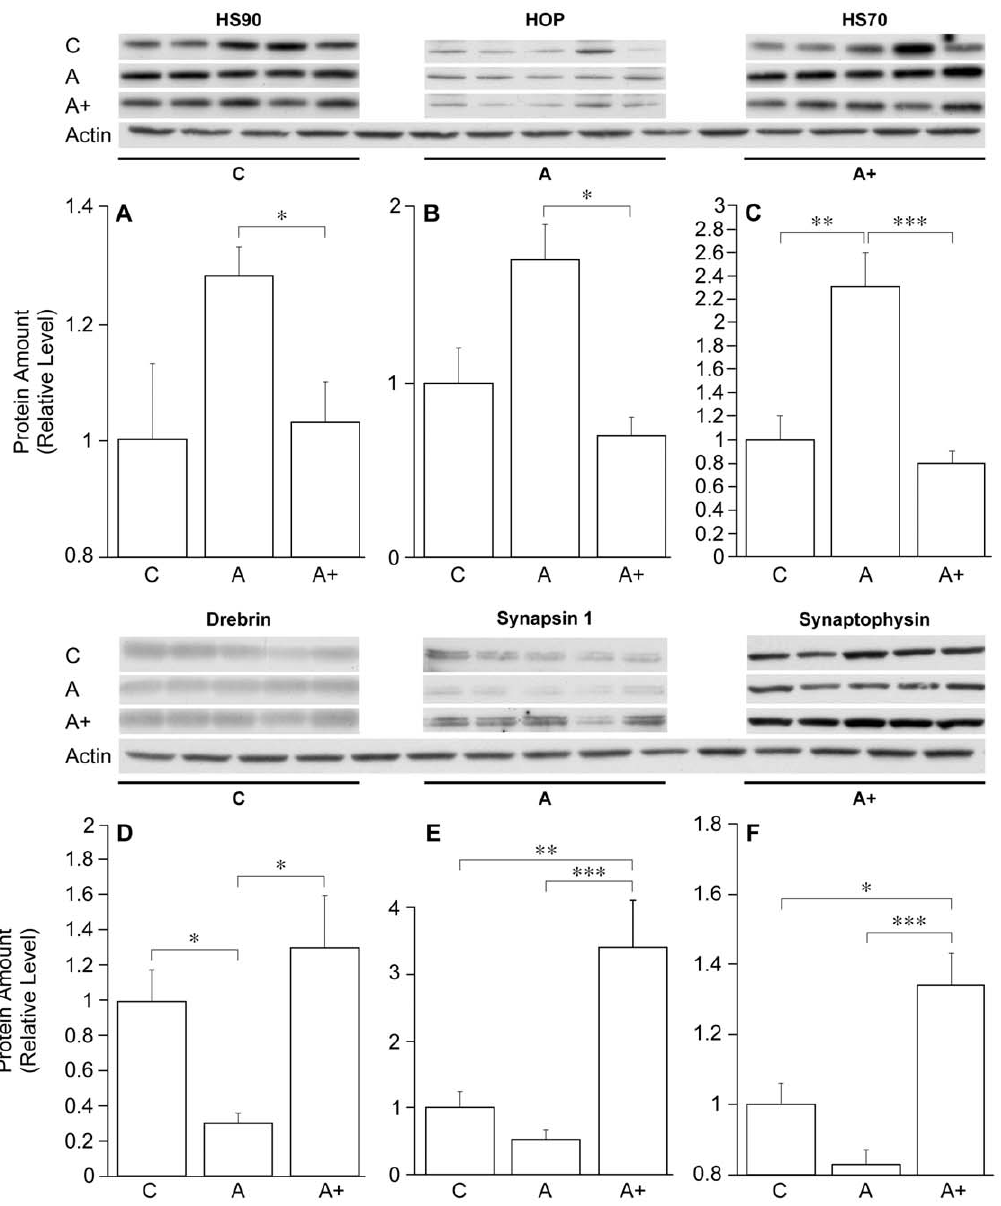
Figure 8. J147 Reduces Heat Shock Protein Stress Response and Increases Markers for Synaptic Function. Cell lysates from hippocampal tissue of line 85 mice fed J147 for 7 months were analyzed by Western blotting. C=control; A=AD transgenic; A + =AD transgenic fed J147. (A) HSP90 levels are decreased in AD transgenic mice fed J147. (B) HOP levels are decreased in AD transgenic mice fed J147. (C) HSP70 levels are increased in AD transgenic mice and these levels are decreased with treatment of J147. (D) Drebrin levels are decreased in AD transgenic mice and J147 treatment restores levels to above control levels. (E) Synapsin-1 levels are decreased in AD transgenic mice and are restored significantly beyond control by J147. (F) Synaptophysin levels are decreased in AD transgenic mice and levels are restored beyond control levels with J147. * P , 0.05, ** P , 0.01), and *** P , 0.001. All data shown are means 6 SEM, n=5 per group.